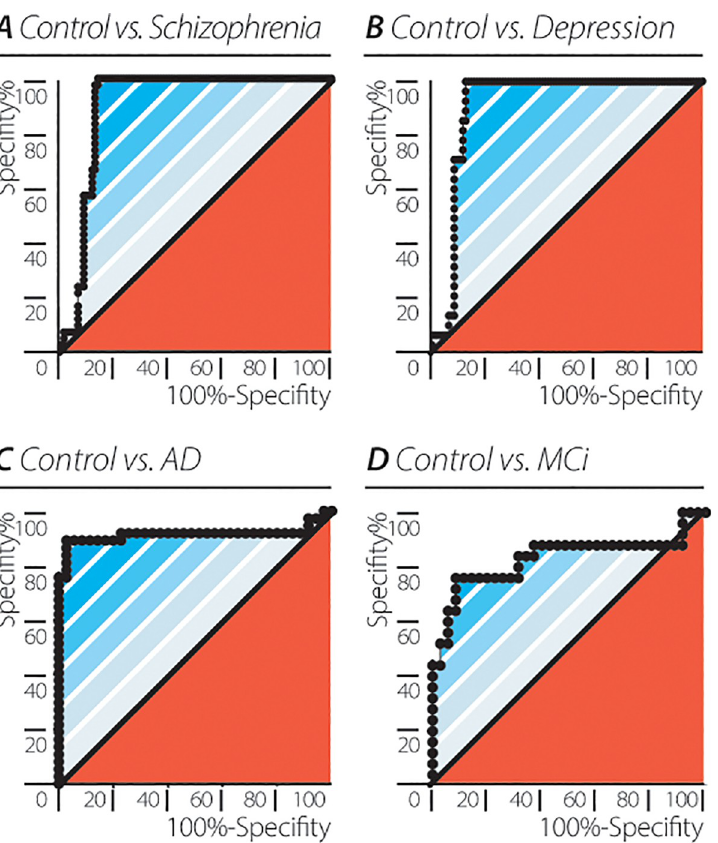
Fig 4. Accuracy of the EEG based quantum potential mean and variability score (qpmvs) in differentiating neuro- psychiatric patient groups from healthy controls. Receiver operating characteristic (ROC) curves for (A) control vs. schizophrenia (AUC = 0.8981 ± 0.028, 95% CI: (0.8426–0.9535), p = < 0.0001). (B) control vs. depression (AUC = 0.9033 ± 0.028, 95% CI: (0.8479–0.9586), p = < 0.0001). (C) control vs. AD (AUC = 0.9143 ± 0.042, 95% CI: (0.8312–0.9974), p = < 0.0001). (D) control vs. MCI (AUC = 0.8309 ± 0.06228, 95% CI: (0.7088–0.9529), p = < 0.0001).